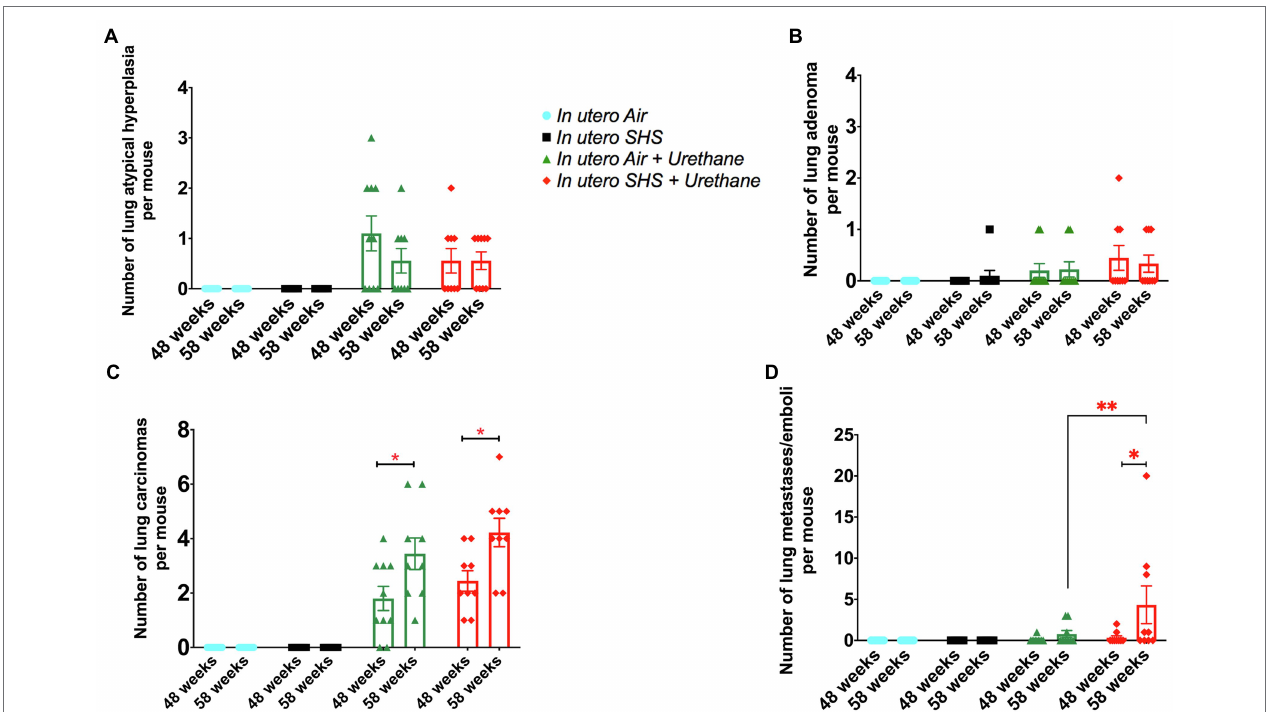
FIGURE 10 | In utero SHS plus adult urethane increased the number of intrapulmonary metastases at 58 weeks. (A) Number of lung atypical hyperplasia observed on H&E stained lung tissue slides. Histopathological evaluation of lungs at 48 and 58 weeks of age in female mouse offspring. N = 9–10 per group, data are expressed as mean ± SEM. (B) Number of lung adenoma observed H&E stained lung tissue slides. Histopathological evaluation of lungs at 48 and 58 weeks of age in female mouse offspring. N = 9–10 per group, data are expressed as mean ± SEM. (C) Number of lung carcinoma observed H&E stained lung tissue slides. Histopathological evaluation of lungs at 48 and 58 weeks of age in female mouse offspring. N = 9–10 per group, data are expressed as mean ± SEM. Student t -test, * p < 0.05: statistically different from respective urethane treated group at 48 weeks of age (time-course effect). (D) Number of lung intrapulmonary metastases observed H&E stained lung tissue slides. Histopathological evaluation of lungs at 48 and 58 weeks of age in female mouse offspring. N = 9–10 per group, data are expressed as mean ± SEM. Student t -test, * p < 0.05: statistically different from respective urethane treated group at 48 weeks of age (time-course effect); ** p < 0.05: statistically different from in utero air plus urethane group at 58 weeks of age ( in utero exposure